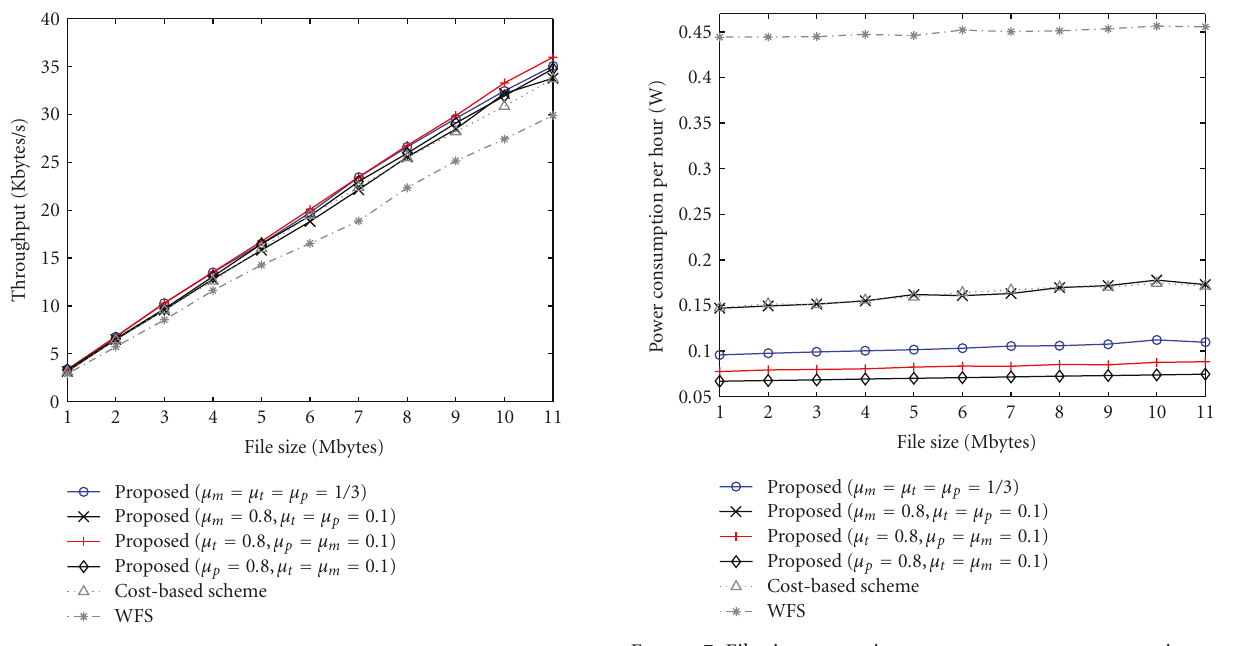
Figure 6: File size per session versus throughput when the TCP tra ffi c ( ρ = 1) is generated.